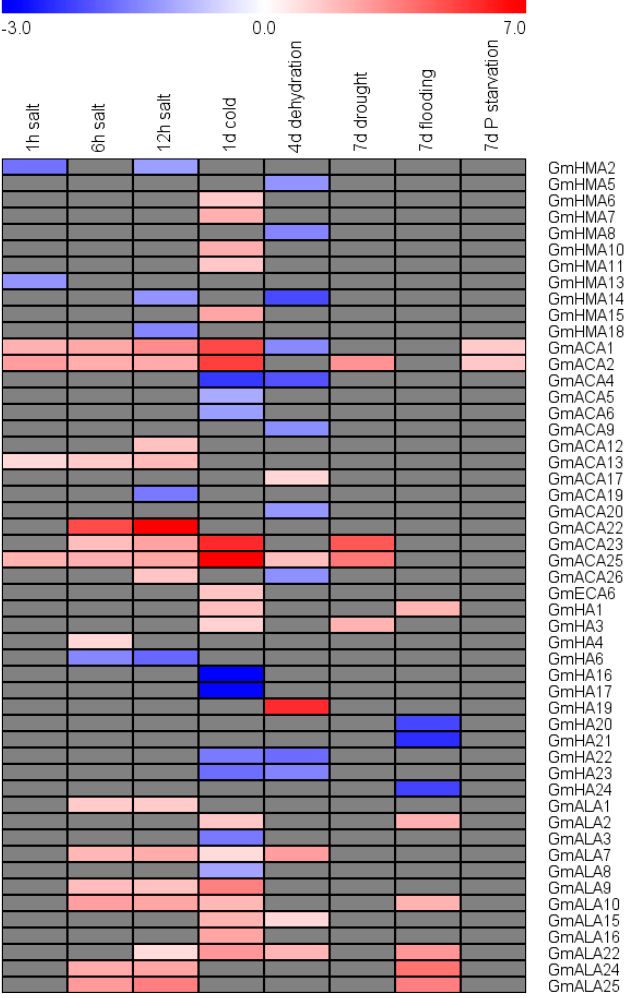
Figure 12. Heatmap representation for the expression profiles of putative genes encoding P-type ATPase proteins under environmental stresses, like short-term salt stress (1 h, 6 h, and 12 h) in roots, 1 d cold stress in shoots, 4 d dehydration stress in shoots, 7 d flooding stress in leaves, 7 d drought stress in leaves, and 7 d phosphate starvation stress in roots: the intensities of the color represent the relative magnitude of fold changes in log2 values according to microarray or high-throughput sequencing data (fold change > 2, and p -value < 0.05). Red color indicates induction, blue color indicates repression, and gray color means no significant change in expression level.